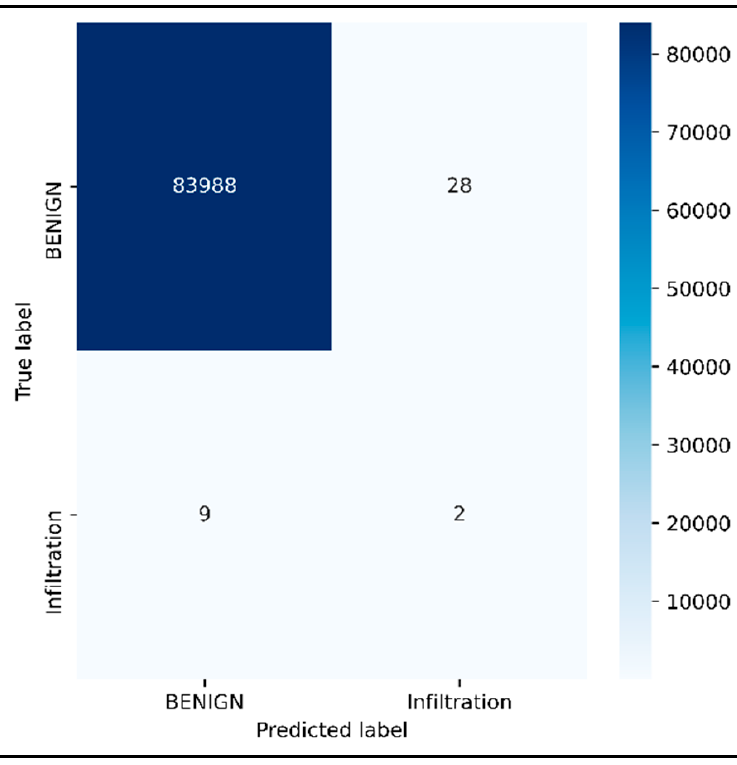
Figure 11. Thursday afternoon confusion matrix. Table 4. Statistical report of Tuesday test dataset.